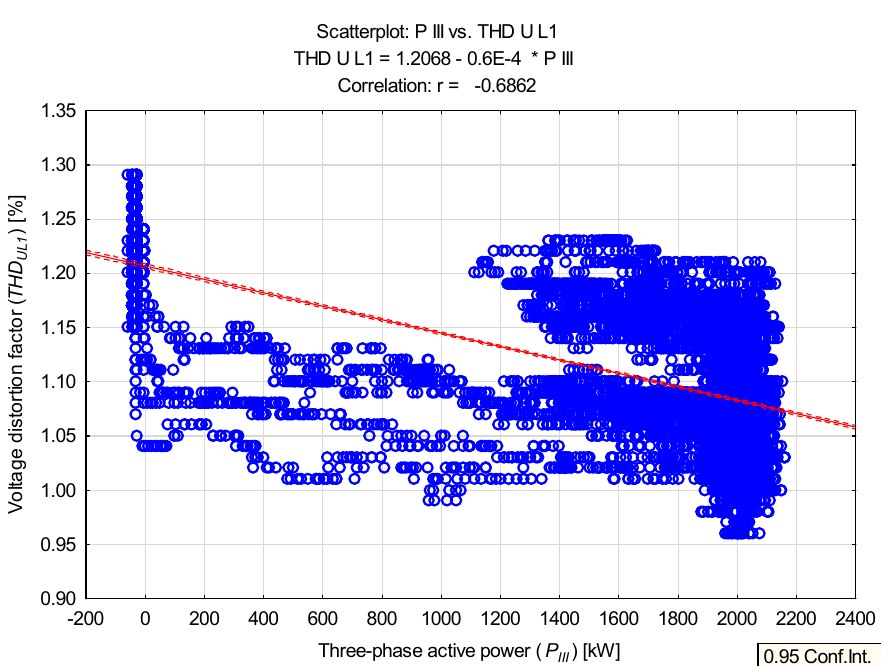
Figure 14. Dependence diagram of the voltage distortion factor ( THD UL 1 ) at the connection point on the three-phase active power ( P III ) generated by the wind power plant.